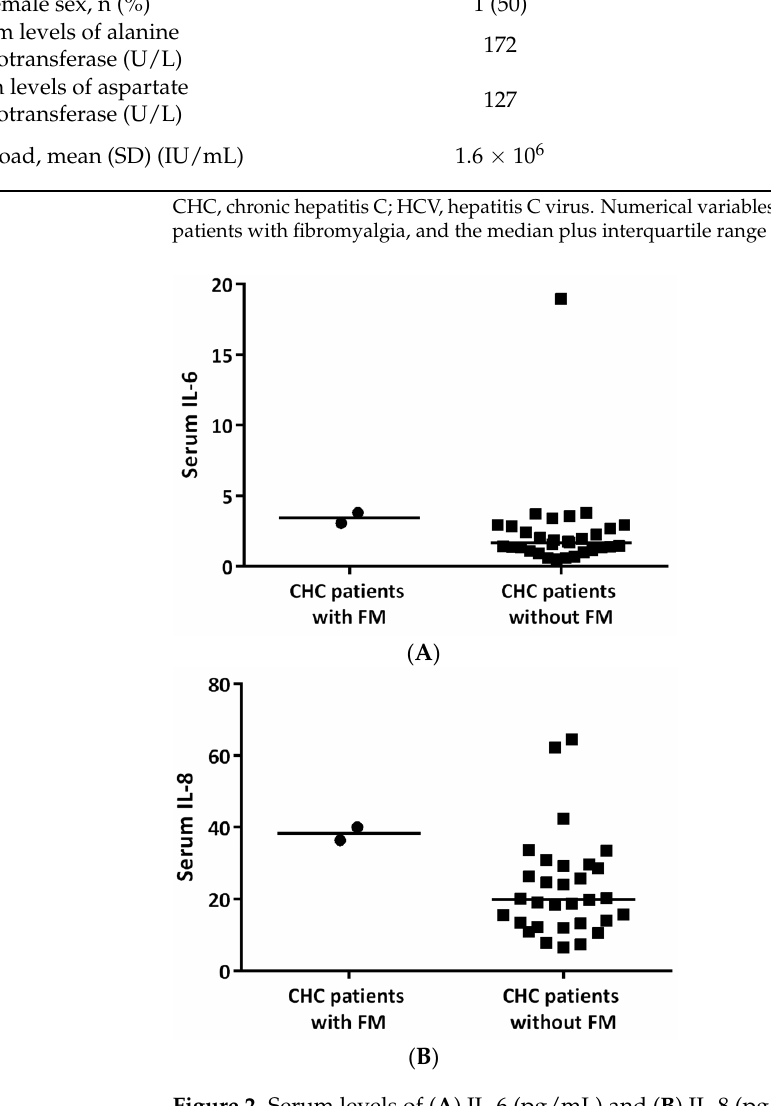
Figure 2. Serum levels of ( A ) IL-6 (pg/mL) and ( B ) IL-8 (pg/mL) between CHC patients with and without FM at baseline. CHC, chronic hepatitis C; FM, fibromyalgia; IL, interleukin. Table 2. Baseline characteristics between CHC patients with and without fibromyalgia.